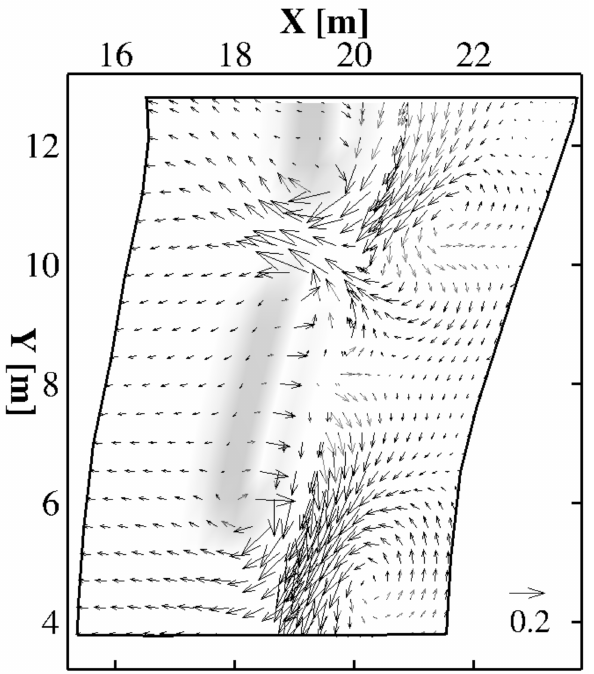
Figure 14. Case 2: Plan view detail of the time averaged (over 120 wave periods) velocity field. Only one out of every four vectors is